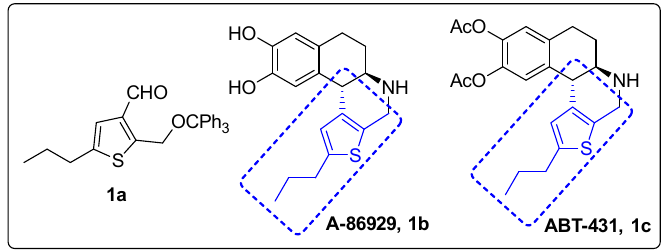
Figure 1. Thiophene fragment in A-86929 and ABT-431.